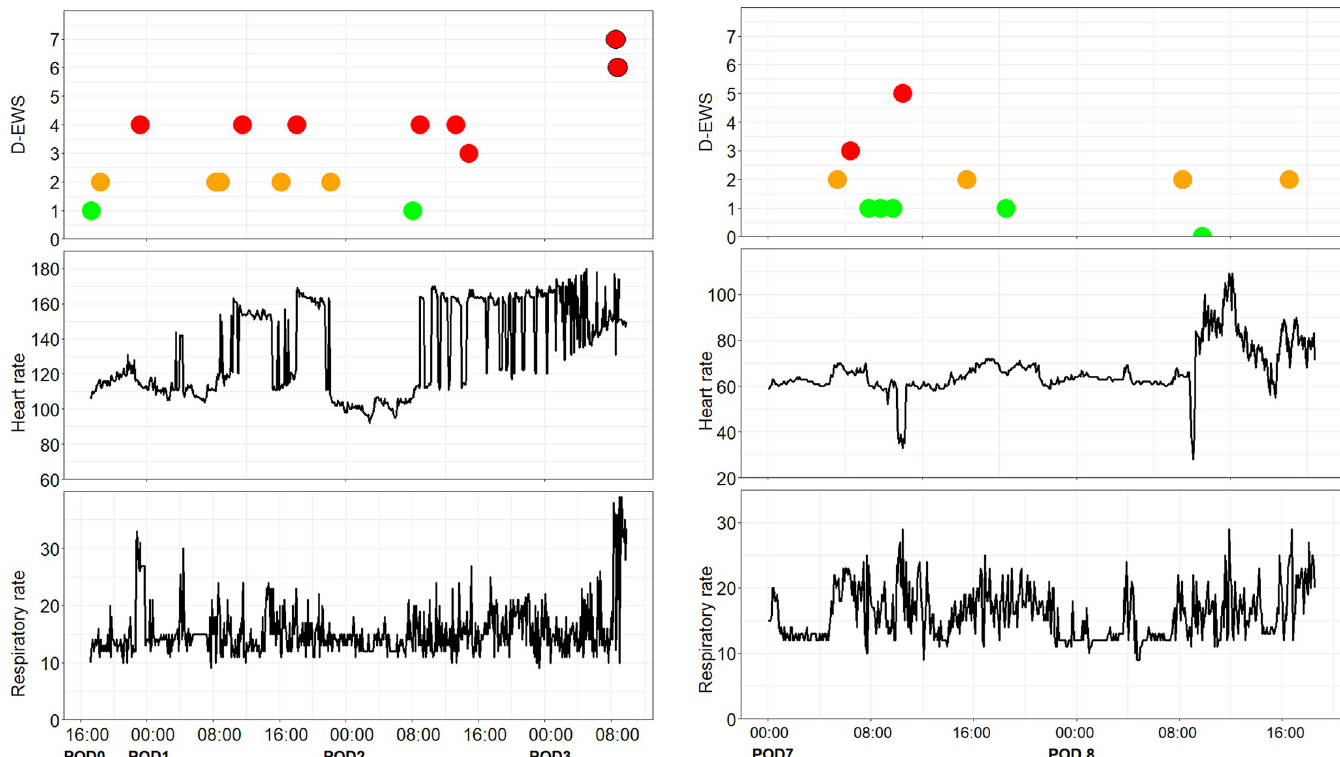
Fig 1. Deviating vital sign trends in two patients who were admitted to the ICU unplanned. (A) Patient #45 (81 years old male for colon resection): Trend data from postoperative day 0 (POD0) 17:00 pm to POD3 10:00 am. On POD1 09:00 am sudden heart rate elevations were detected resulted in D-EWS score of 3 following an electrocardiogram which diagnosed sinus tachycardia but no further action was required. The next day the sinus tachycardia was present several episodes. In the morning of POD3 the patient became respiratory insufficient (with full MEWS scores 6 and 7) following a diagnostic laparoscopic but was negative for abdominal seps. Post-surgical the patient was admitted to the ICU with diagnosis of pneumosepis and eventually died. (B) Patient #53 (76 year old female for colon resection): Trend data from POD7 00:00 am to POD8 18:45 pm. On 10:45 am sudden heart rate changes were detected resulted in D-EWS score of 3. The next morning about 10:00 am the heart rate deviated again till patient returned to the operation theater for laparotomy. Eventually abdominal sepsis was diagnosed and postoperatively admitted to the ICU.